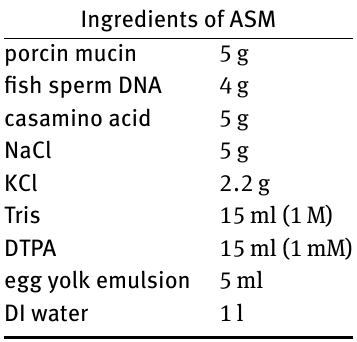
Table 1: The ingredients of ASM. Adapted from